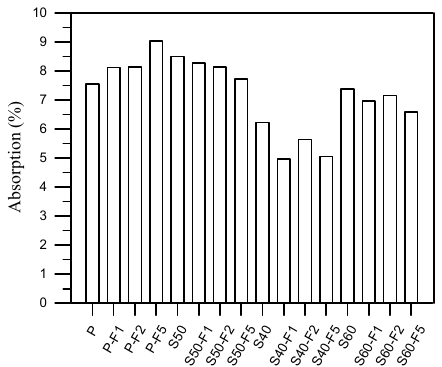
Figure 7. Absorption results of all samples at 56